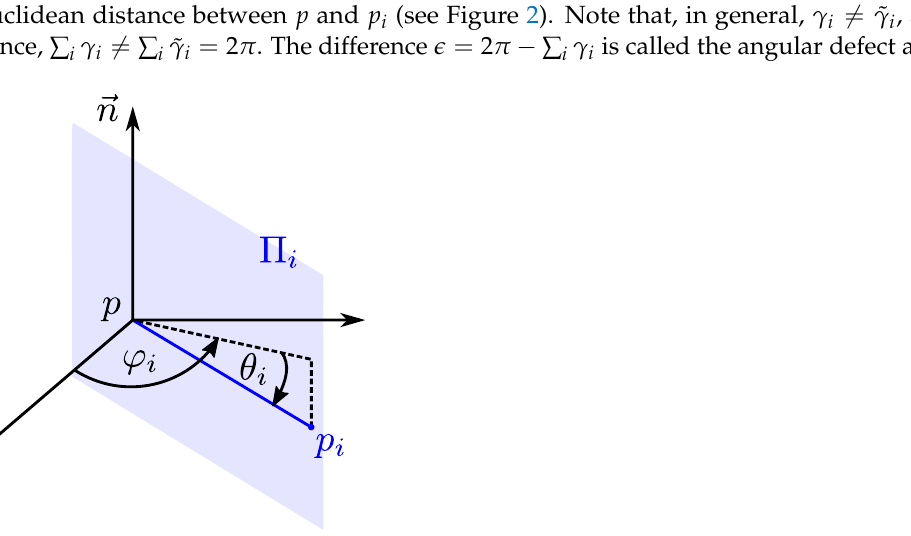
Figure 1. Definition of point p i in spherical coordinates and the position of the plane Π i in relation to p and p i . Thereby, the angle ϕ i describes the tilt of the plain Π i around the normal vector (cid:126) n and the position of the point p i in to the plain spanned by the other two axes of the coordinate system. The angle θ i defines the position of p i with respect to the latter